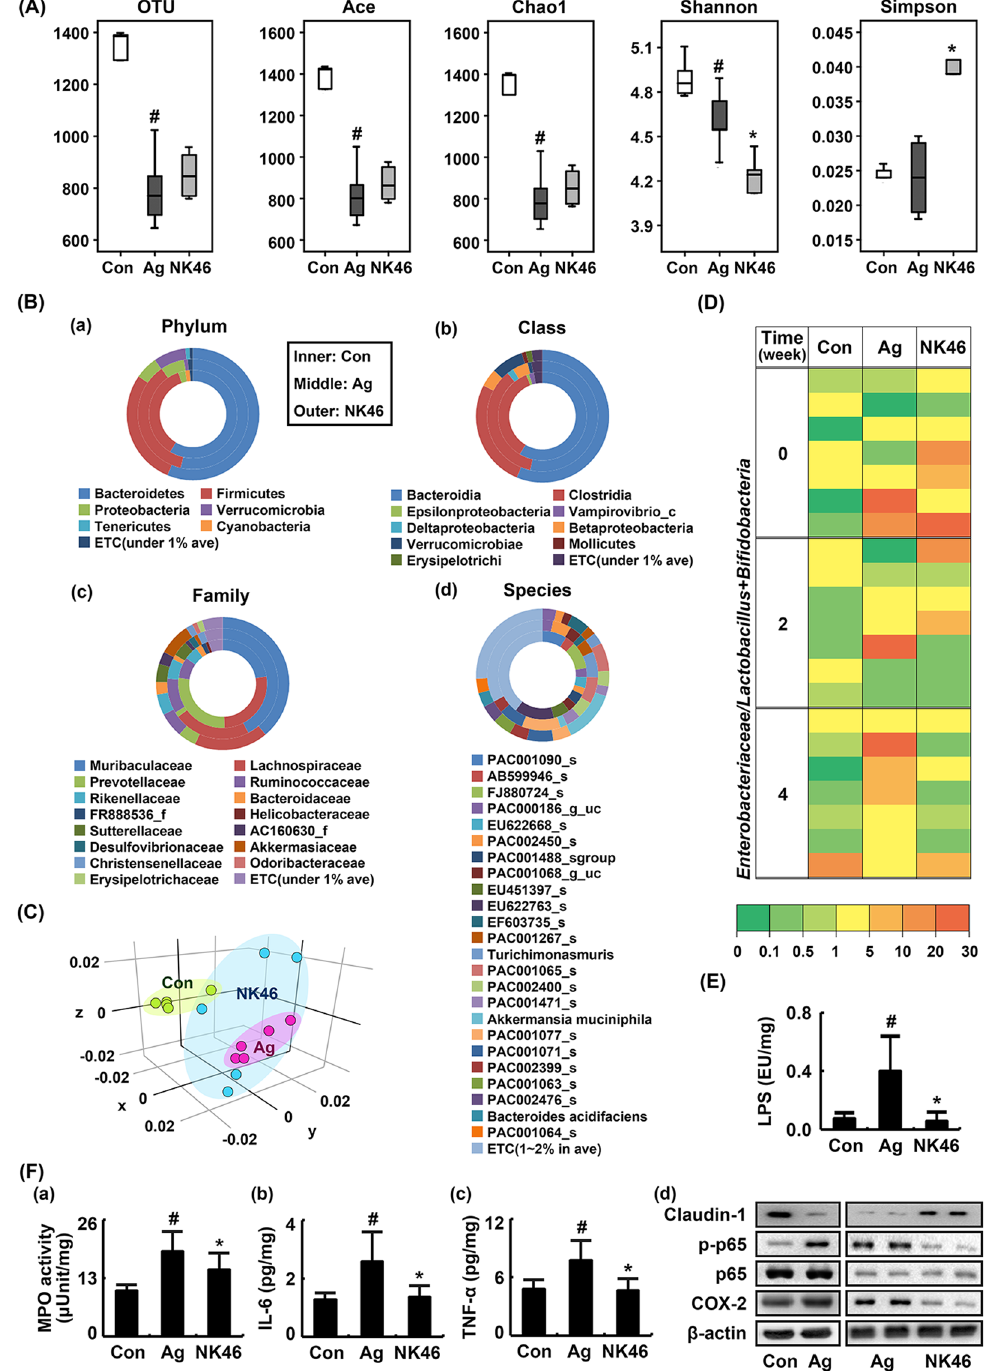
Figure 4. NK46 modified the gut microbiota composition in aged mice. ( A ) Effect on the number of sequences analyzed, operational taxonomic units (OTUs), abundance-based coverage estimator (ACE), Chao1, Shannon, and Simpson. ( B ) Effect on the fecal microbiota composition: phylum (a), class (b), family (c), and species (d). ( C ) Principal coordinate analysis (PCoA) plot. The plot shows the clustering pattern among control (Con), vehicle- (Ag), or NK46-treated aged mice (NK46) based on weighted pairwise Fast UniFrac analysis (n = 5). ( D ) Effect on the ratio of Enterobacteriaceae populations to bifidobacteria plus lactobacilli populations, assessed by the selective media BL and DHL agar plates (n = 6). ( E ) Effect on the fecal LPS levels. ( F ) Effect on the myeloperoxidase (MPO) activity (a) and IL-6 (b), TNF- α (c), claudin-1 and COX-2 expression, and NF- κ B activation (d) in the colon. IL-6 and TNF- α levels were measured using ELISA and COX-2, claudin-1, p65, p-p65 were using immunoblotting. Test agent (Ag, vehicle alone; NK46, 1 × 10 9 CFU/mouse/day) was orally administered for 1 month in aged mice. Control mice (Con) were treated with vehicle alone. All data were expressed as mean ± SD (n = 6). # p < 0.05 vs. Con group. * p < 0.05 vs. Ag